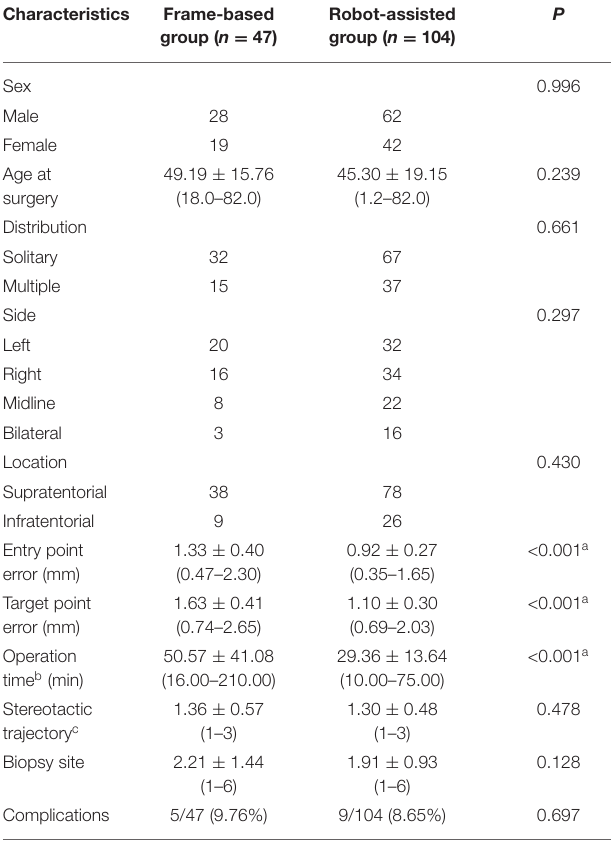
TABLE 1 | Summary of the demographic and surgical characteristics in